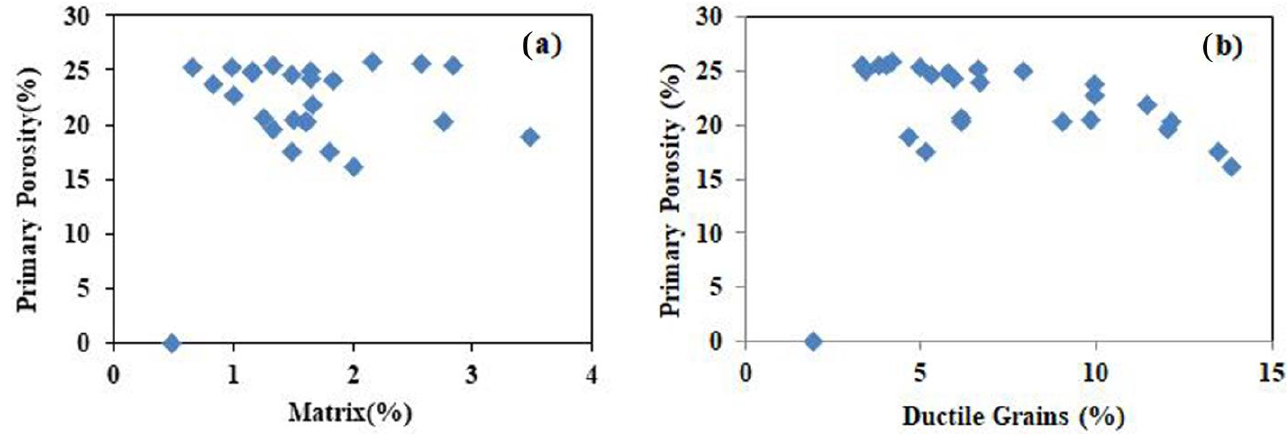
Figure 13. Relation between ( a ) primary porosity (%) vs. matrix (%) and ( b ) primary porosity (%) vs. ductile grains (%).